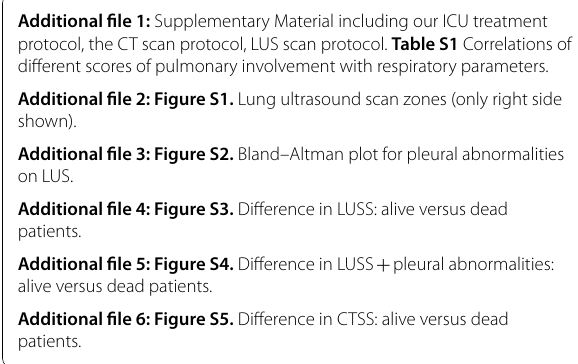
pleural abnormalities: +